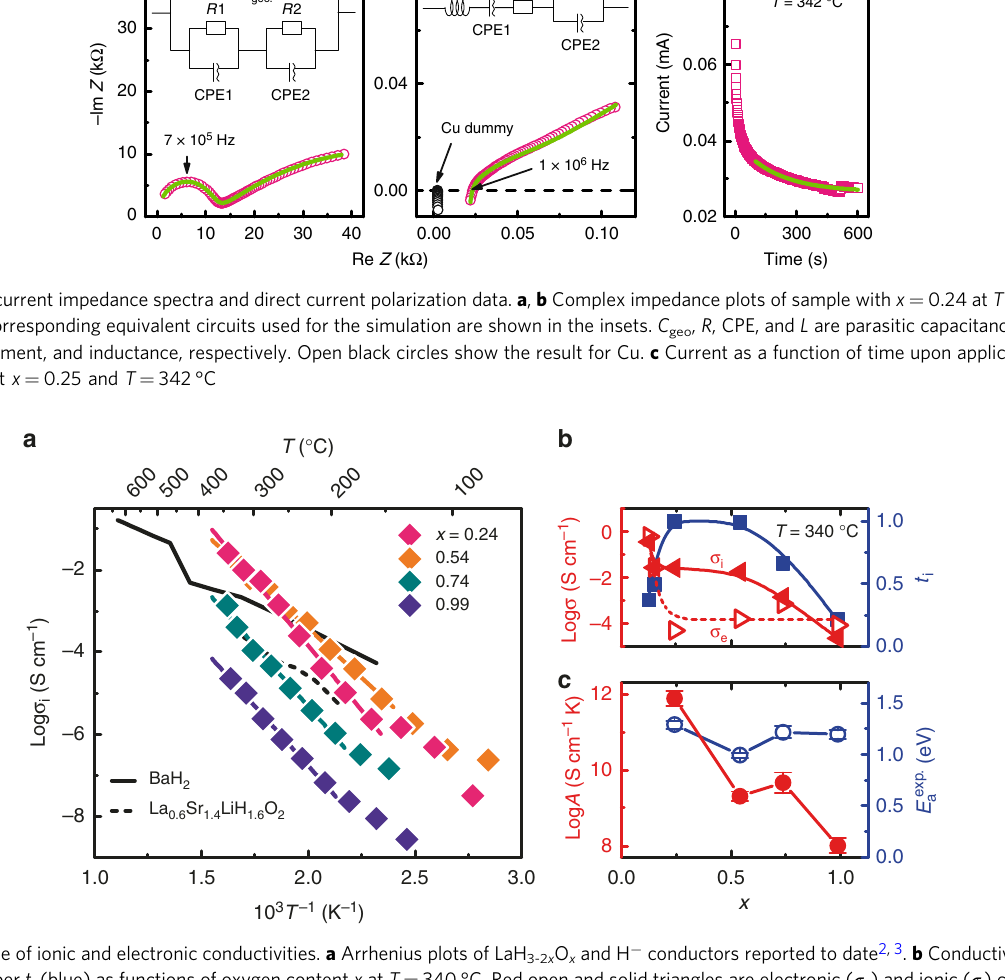
Fig. 3 x dependence of ionic and electronic conductivities. a Arrhenius plots of LaH 3-2 x O x and H − conductors reported to date 2, 3 . b Conductivity (red) and ion transport number t i (blue) as functions of oxygen content x at T = 340 °C. Red open and solid triangles are electronic ( σ e ) and ionic ( σ i ) conductivities, respectively. c Logarithm of pre-exponential factor A (red) and activation energy E a exp (blue) as functions of oxygen content x , as derived from Eq.